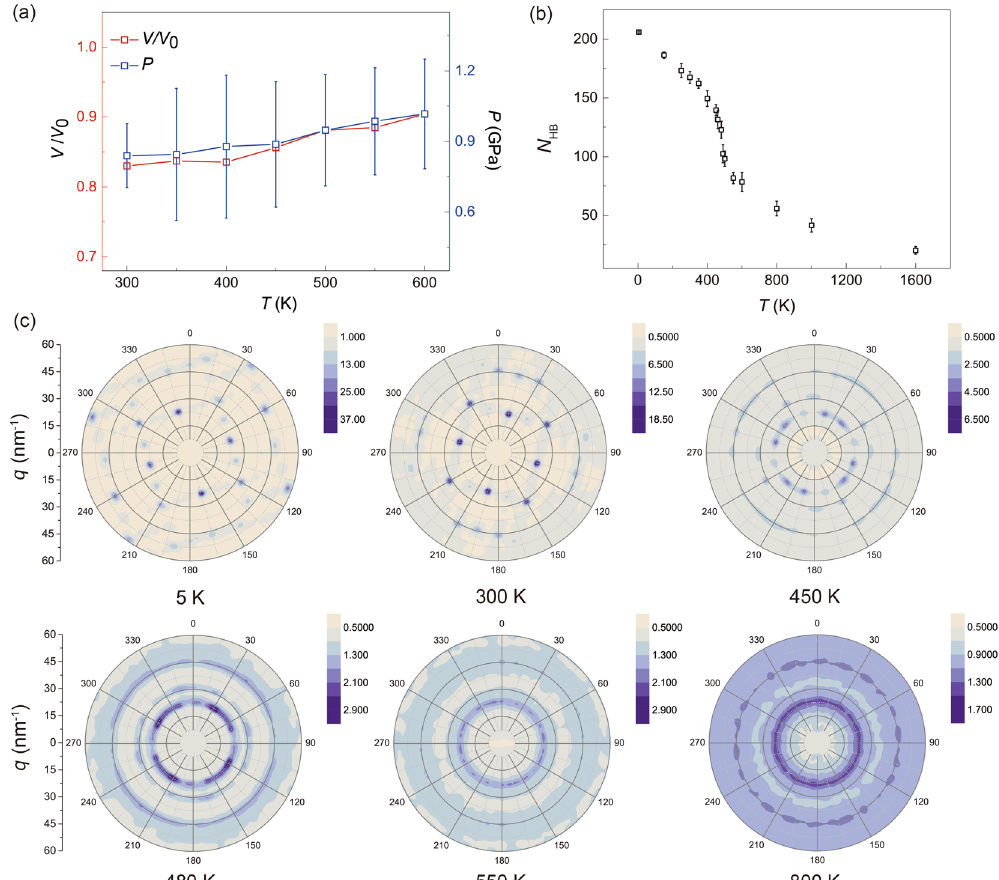
Figure 3. ( a ) Pressure, volume changes as function of T , where V 0 is volume of bulk water at standard atomosphere, for N W = 115 in the 3D EW model. ( b ) Number of hydrogen bonds, N HB , in the EW, plotted as a function of temperature. The error bars measure the thermodynamic fluctuations. ( c ) Structure factors of monolayer EW, demonstrating a solid-to-fluid phase transition at ~480–490